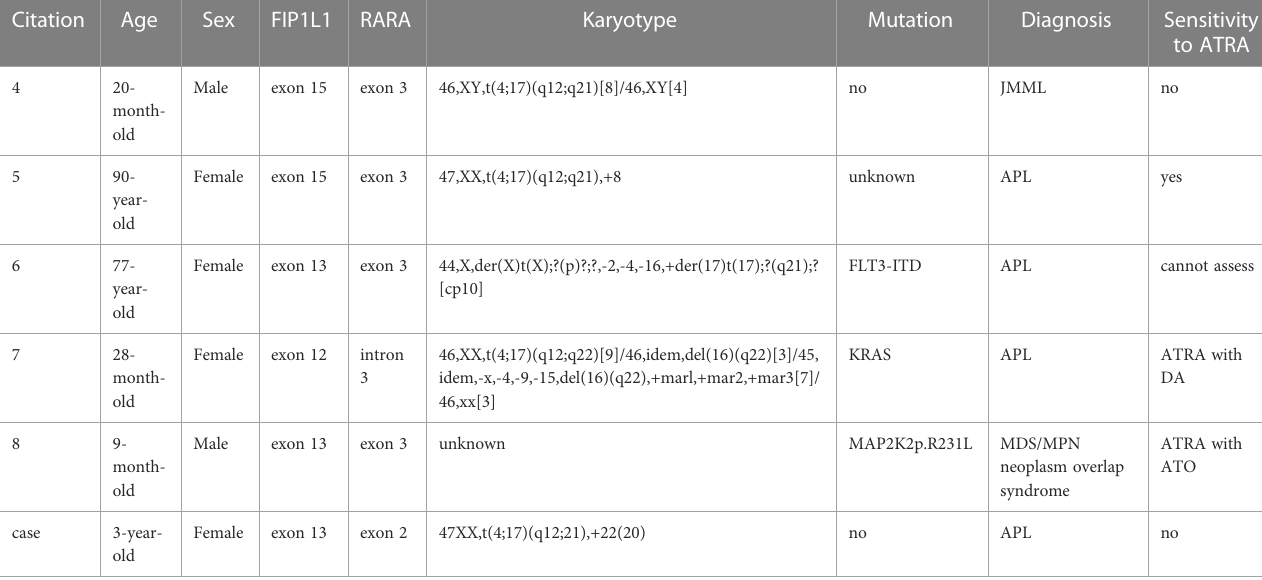
TABLE 1 Characteristics of reported myeloid neoplasms with FIP1L1::RARA.